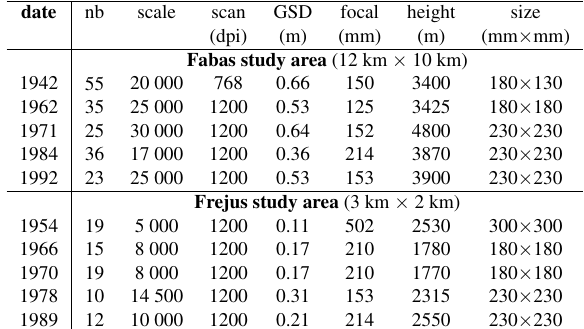
Table 1. Aerial survey datasets. nb : number of images of the aerial survey; scale : mapping scale of the aerial survey; scan : the scan resolution during digitization; GSD : an estimation of the ground sample distance; focal : the focal length of the camera; height : the flight height of the aerial survey; size : the physical size of the archival photographs.